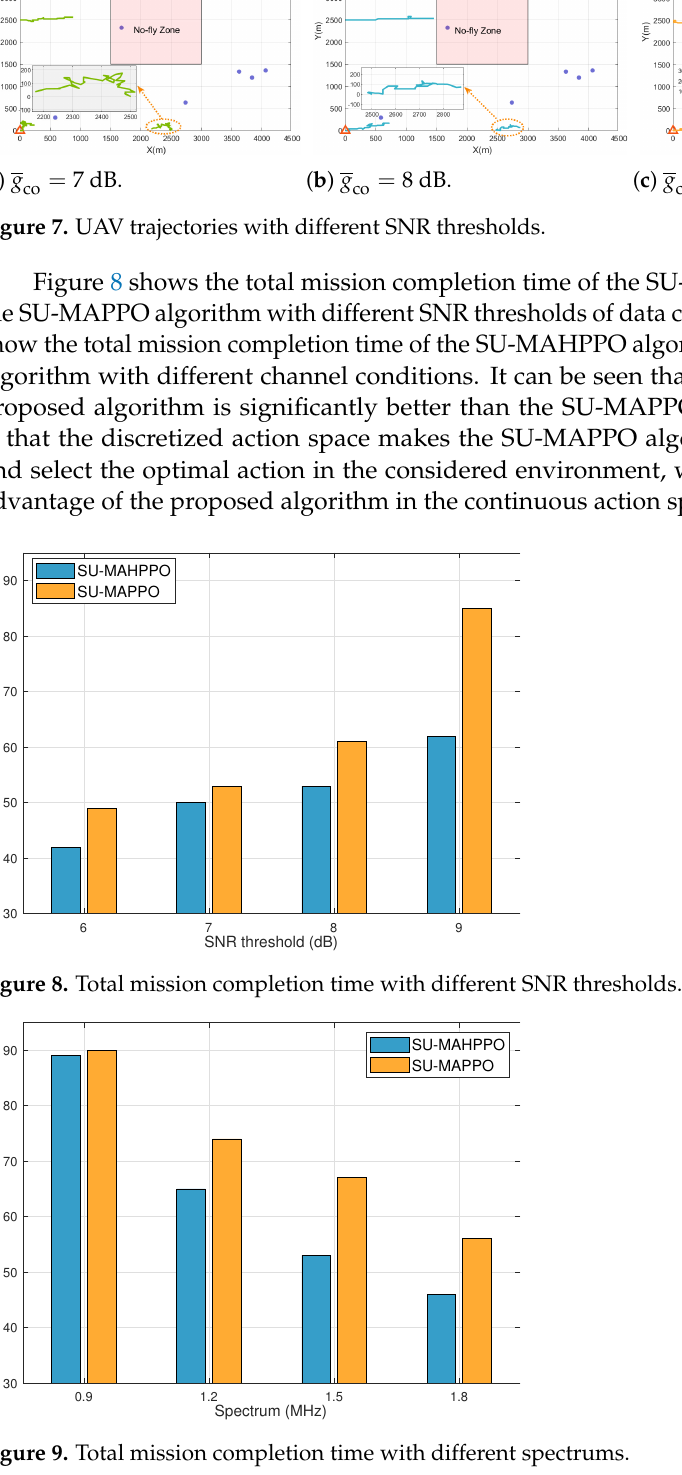
Figure 9. Total mission completion time with different